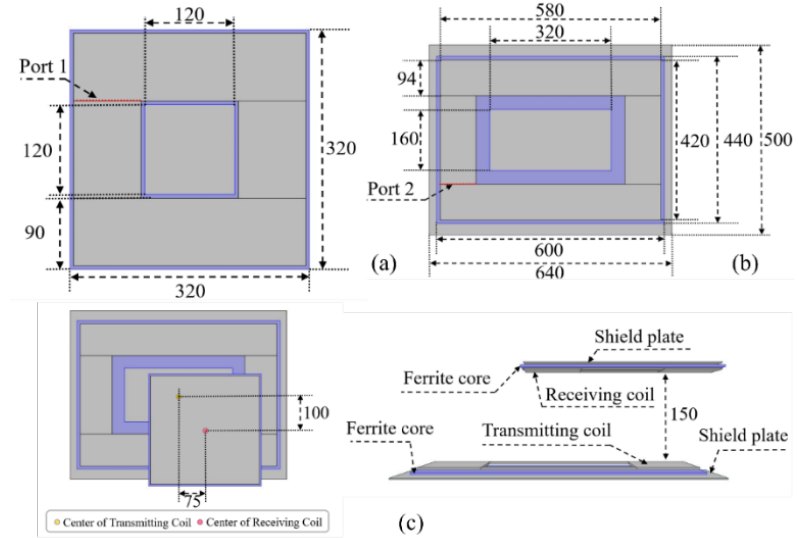
Figure 2. Detailed structure of the wireless power transfer (WPT) system (unit: mm). ( a ) Receiving coils (bottom view), ( b ) transmitting coils (top view), and ( c ) relative position of the receiving and transmitting coils.